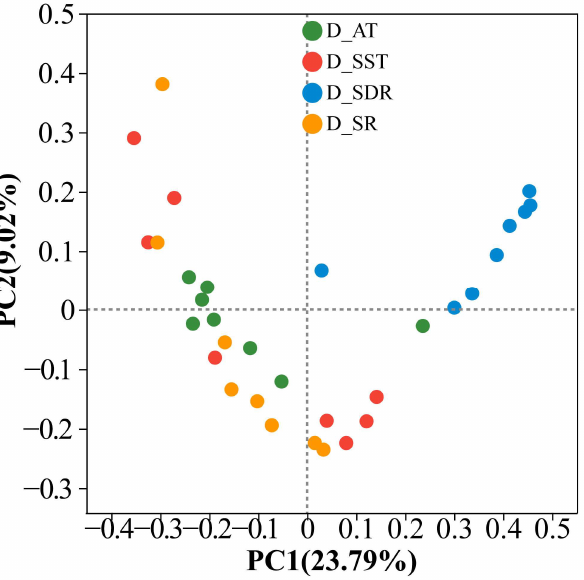
Figure 3. PCoA using unweighted UniFrac distances matrix to calculate Plant D samples. AT: aeration tank; SST: secondary settling tank; SDR: sludge dewatering room; SR: screen room; D: Plant D.